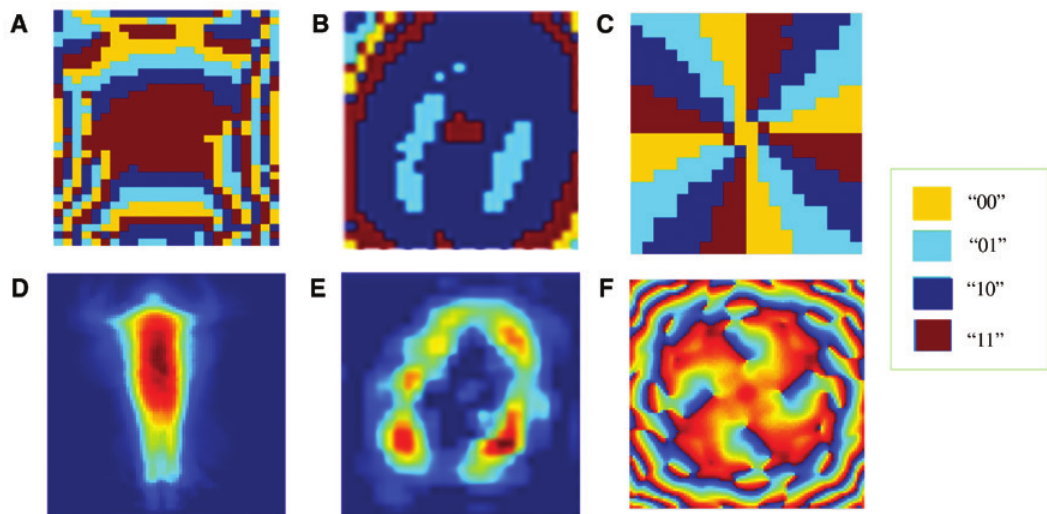
Figure 5: Electromagnetic radiations of the 2-bit reflection-type information metasurface shown in Figure 2. (D)–(F) The human-body like radiation, the digit-like radiation, and the OAM-carrying beam radiation, respectively. The corresponding 2-bit coding patterns are also provided in Figure 5(A)–(C), respectively. Adapted from